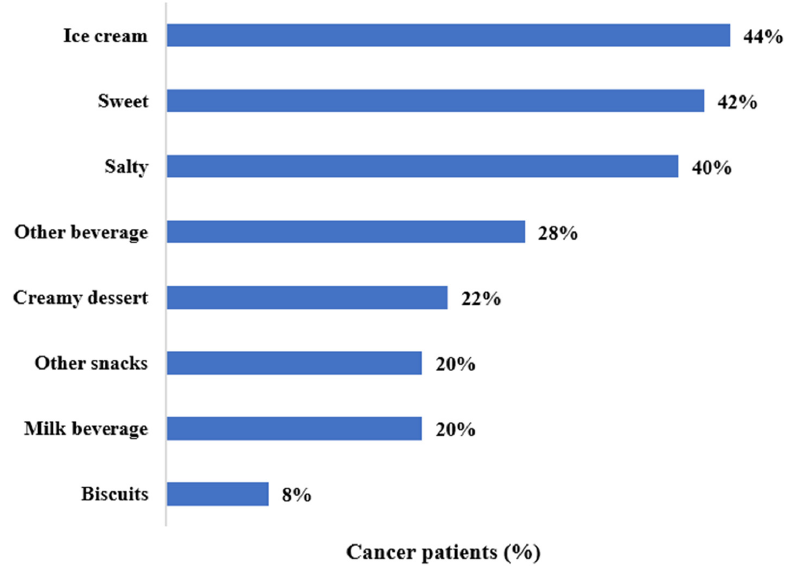
Figure 2. Preferred types of snacks. Distribution of most frequently reported foods or flavors that patients preferred in the preceding month among individuals with cancer.